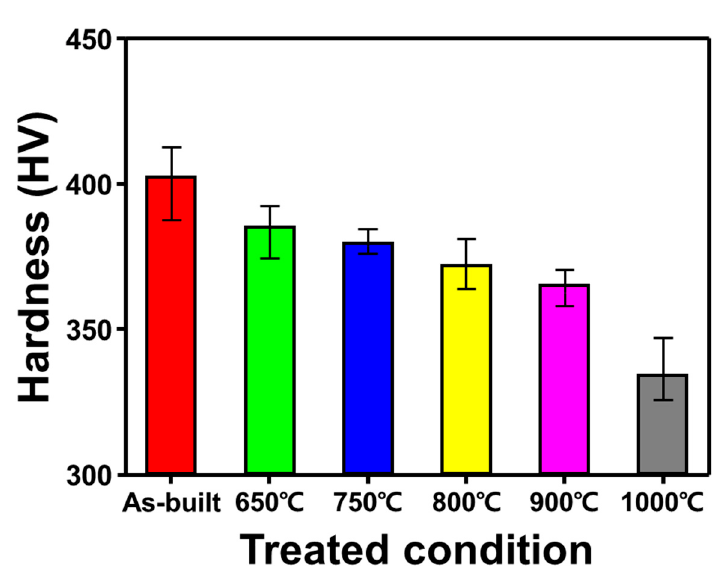
Figure 5. Micro Vickers hardness of SLM Ti ‐ 6Al ‐ 4V specimens heat ‐ treated at various